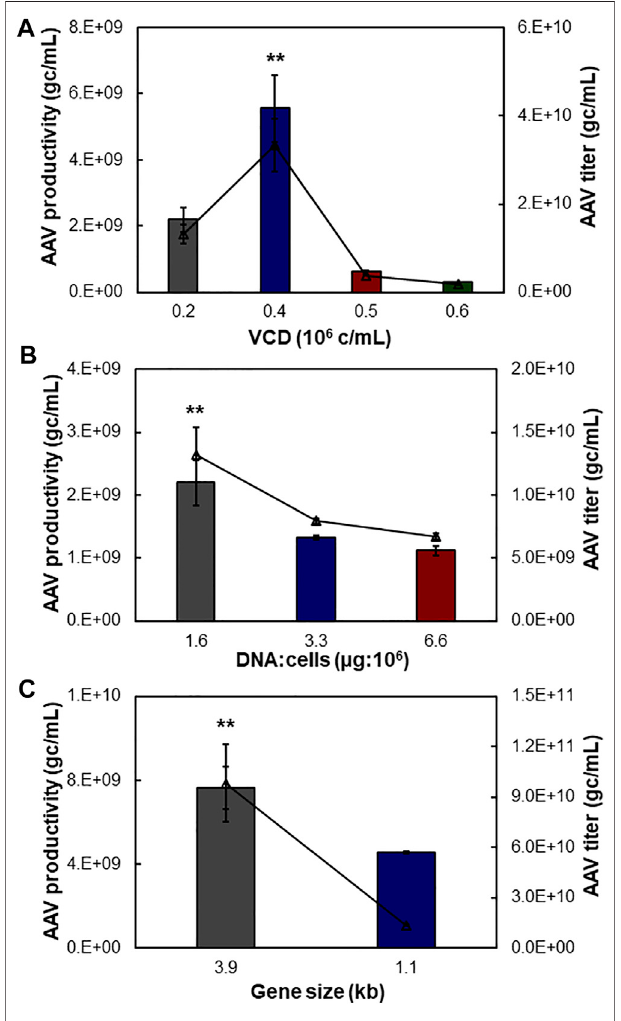
FIGURE 4 | Process optimization of suspensive AAV production. The pAAVplasmidcarrying3.9 kbofNLucfusedgeneswasusedtotransfectHEK 293F cells with duplication. (A) Effect of transfection viable cell density (VCD) on AAV production. (B) Effect of ratio of plasmid DNA (µg) and host cell number (10 6 cells). (C) Effect ofgenesizeclonedinpAAV expression plasmid. Both 3.9 and 1.1 kb of insert genes were tested. ** p ≤ 0.05.